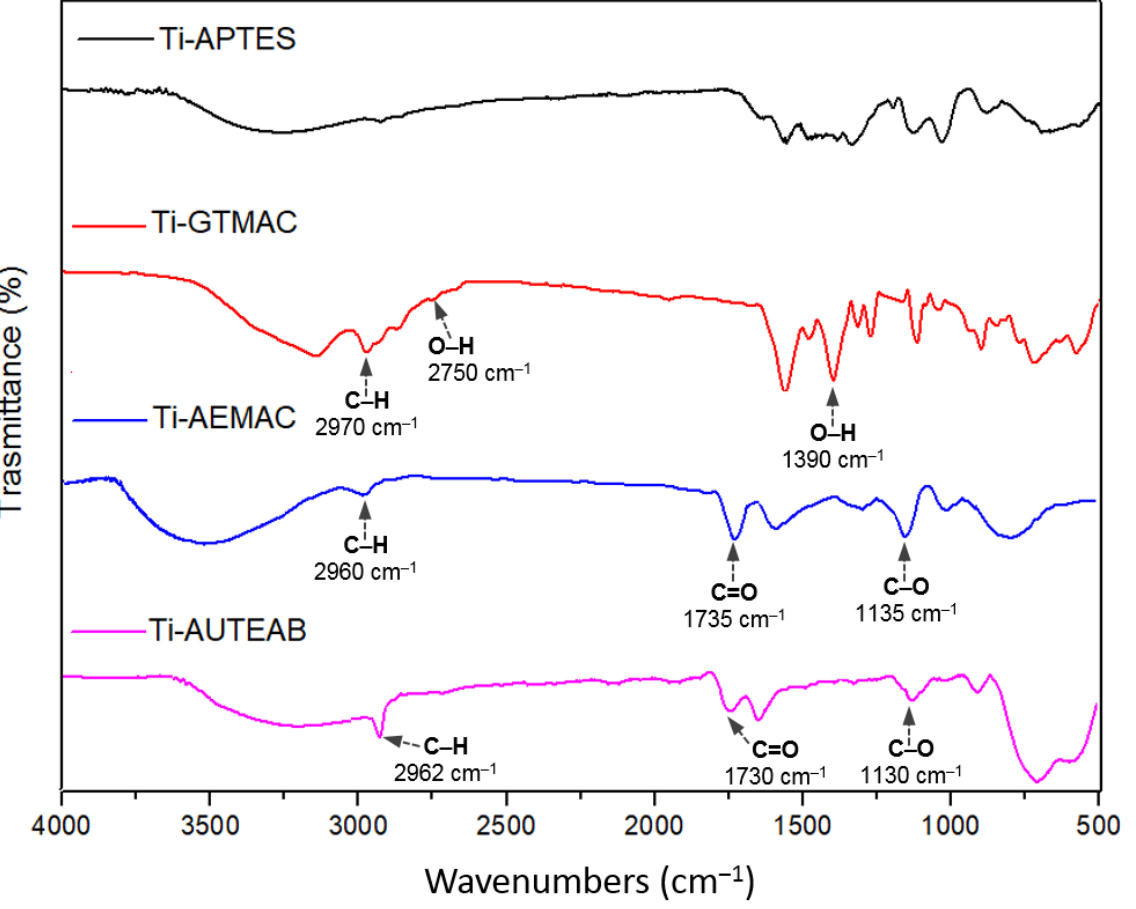
Figure 6. FTIR spectra of Ti-AEMAC, Ti-GTMAC, and Ti-AUTEAB samples, compared with Ti- APTES sample.